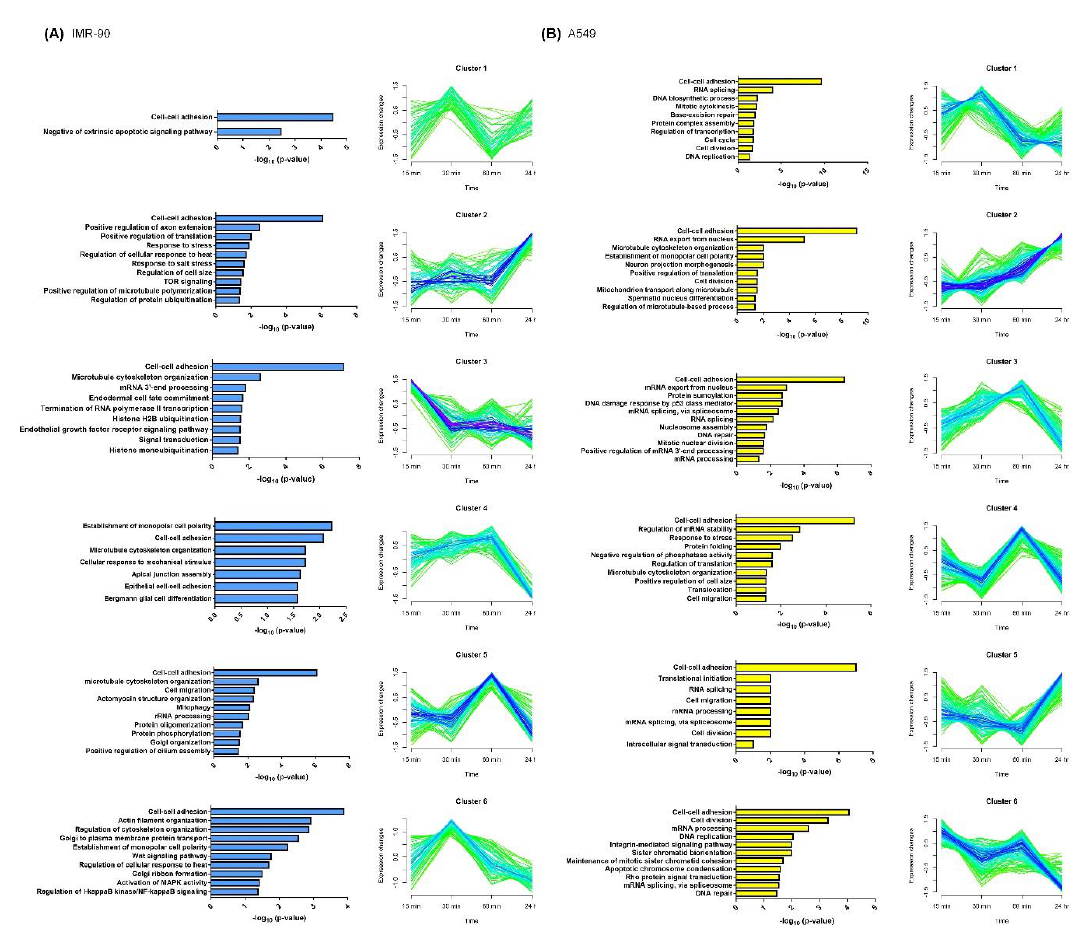
Figure 4. Fuzzy c-means clustering and gene ontology analysis in IMR-90 cells ( A ) and A549 cells ( B ). All phosphosites were classified into six clusters using the bioconductor R package named “Mfuzz”. Blue represents the phosphoproteins that showed significant changes and green means phosphoproteins with no obvious change. Phosphoproteins enriched in different clusters were further analyzed with gene ontology using the Database for Annotation, Visualization and Integrated Discovery (DAVID).